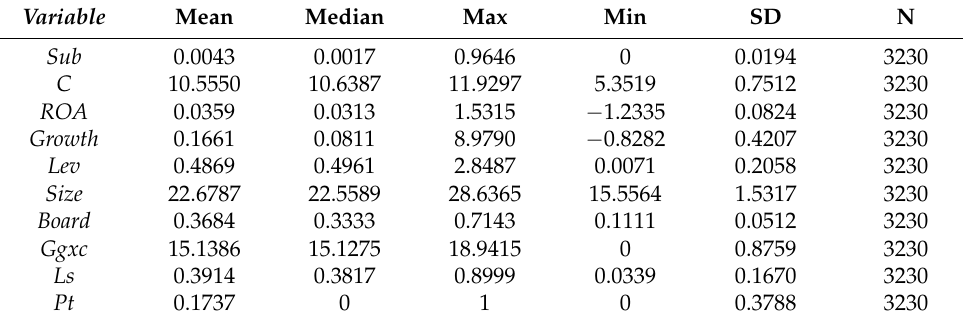
Table 1. Descriptive statistics.